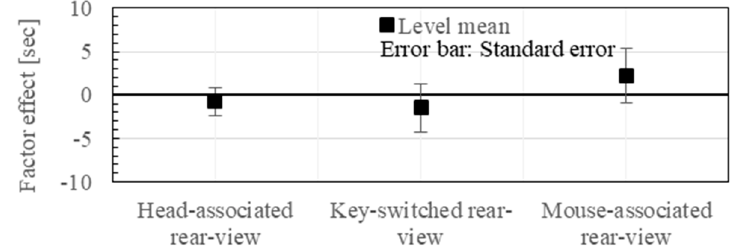
Figure 11. Experimental results of the pose-reproduction. The pose-presenting mode factor effect on elapsed time where the effects of the subject and the pose factor together with the global mean were removed.